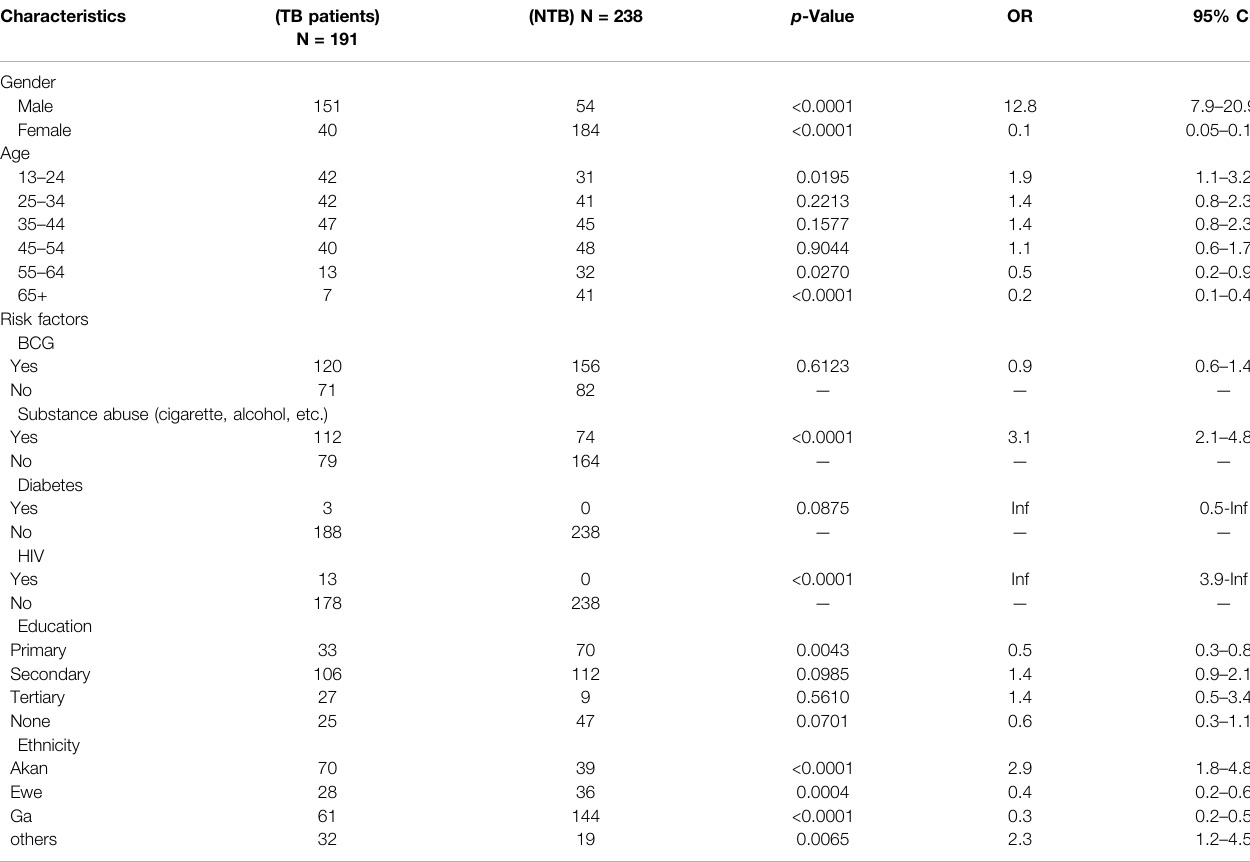
TABLE 1 | Demographic characteristics of patients. Characteristics